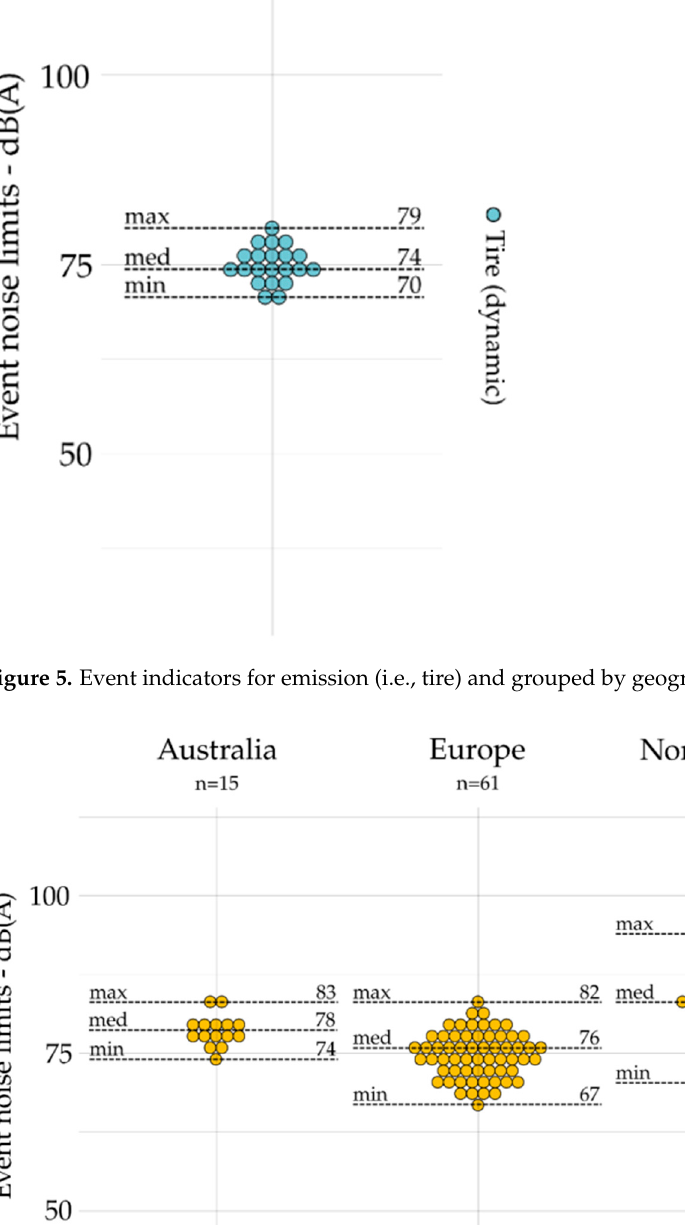
Figure 4. Event indicators for emission (i.e., exhaust) and grouped by geographic area ( n = 116).